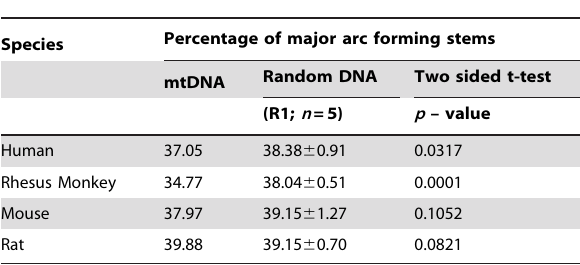
Table 1. Abundance of stem-loop motifs in mtDNA and random DNA